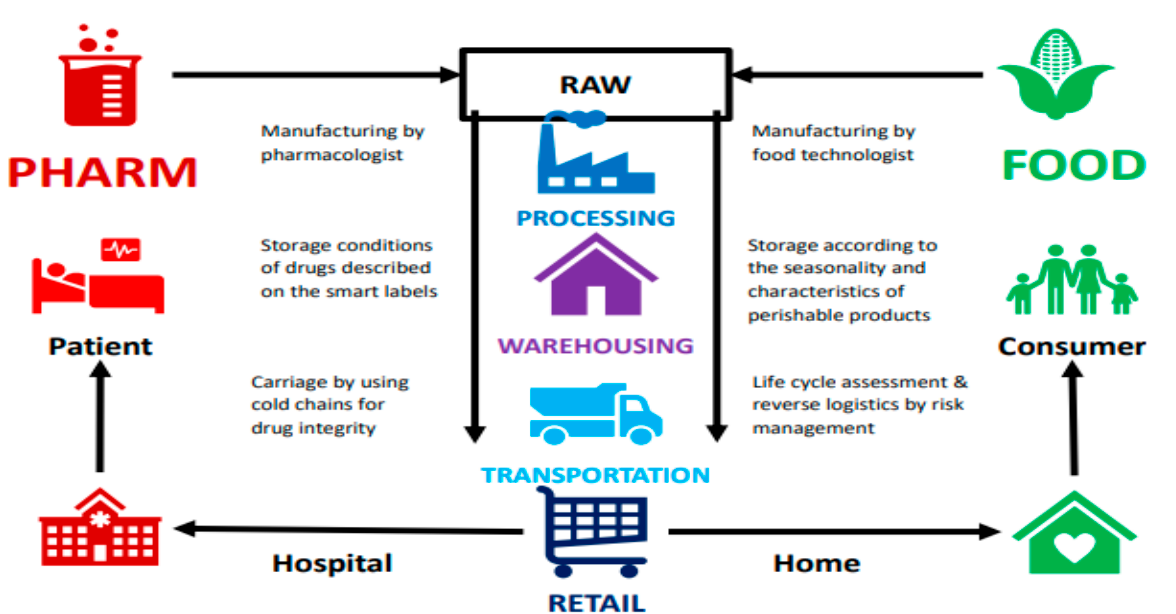
Figure 5. Similarities between FSC & PSC and cold chain importance.